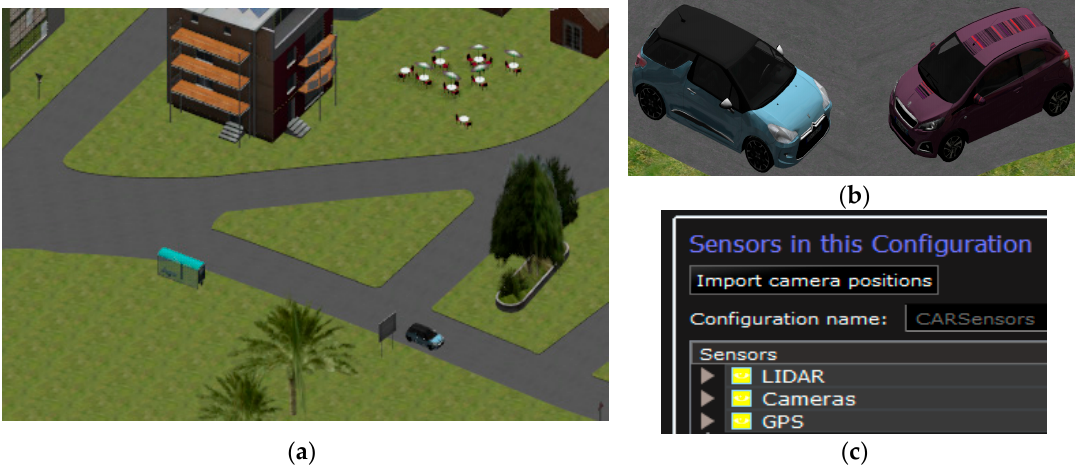
Figure 3. Traffic scenario in SCANeR. ( a ) Aerial view of simulation scenario; ( b ) vehicle models and virtual CPS; ( c ) sensor